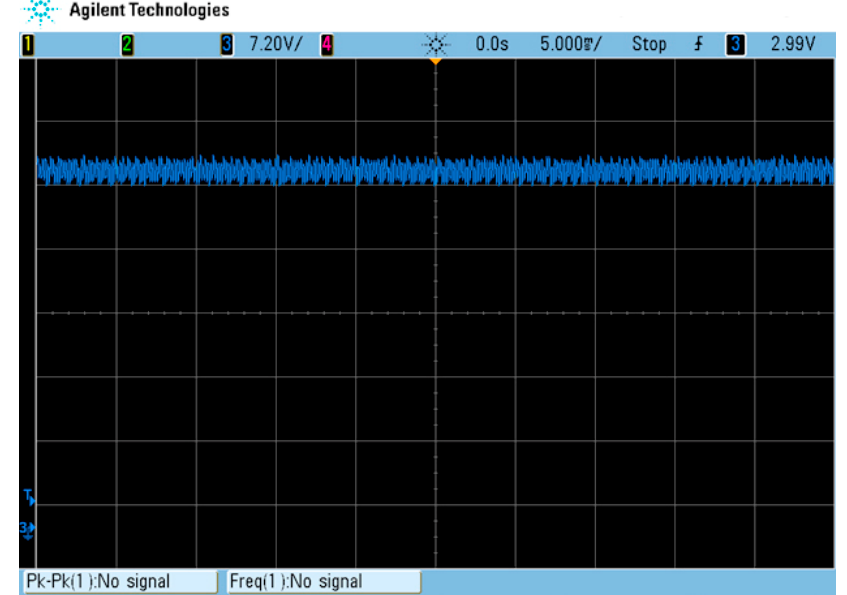
Figure 13. Rectified voltage before filtering.